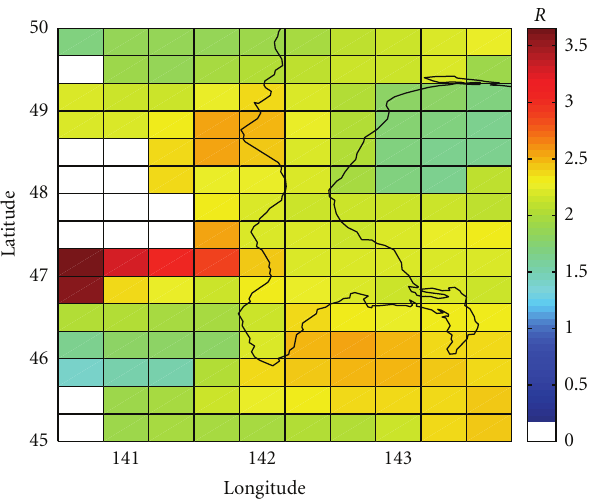
Figure 8: Temporary component of the SEM model—sequence of values of parameter of metastability p in spatial-temporary surrounding of earthquakes of the catalogue 2. The groups of the events with higher p values ( p > 0 . 55), occurred before and after the Nevelsk earthquake, are marked out by the